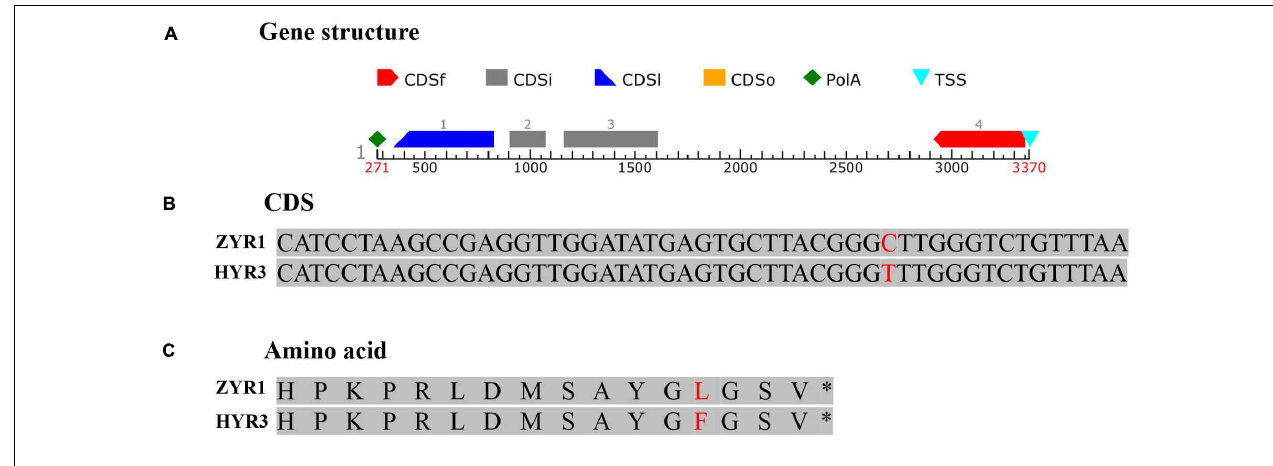
FIGURE 4 | The gene structure and mutational pattern of gene Rs392880 in HYR3. (A) The structure of gene Rs392880 . (B) The SNP in gene Rs392880 . (C) The mutational pattern in the level of amino acids of Rs392880 . TABLE 1 | Statistical summary of the transcriptome assembly for ZYR1 and